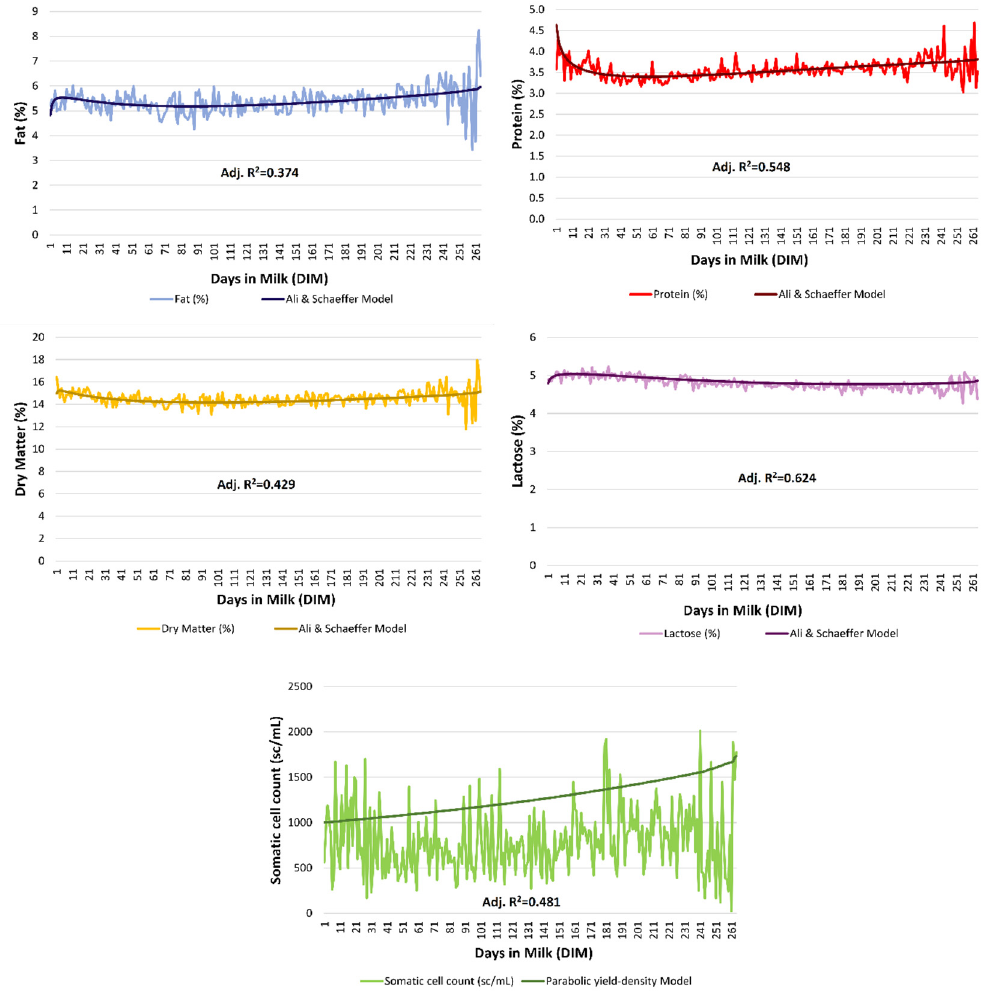
Figure 1. Graphic representation of best-fitting models for milk composition traits in Murciano-Granadina goats; Ali and Schae ff er model (ALISCH) for fat (%), protein (%), dry Matter (%), and lactose (%) and the parabolic yield density model (PARYLDENS) for somatic cell count (sc / mL), respectively.